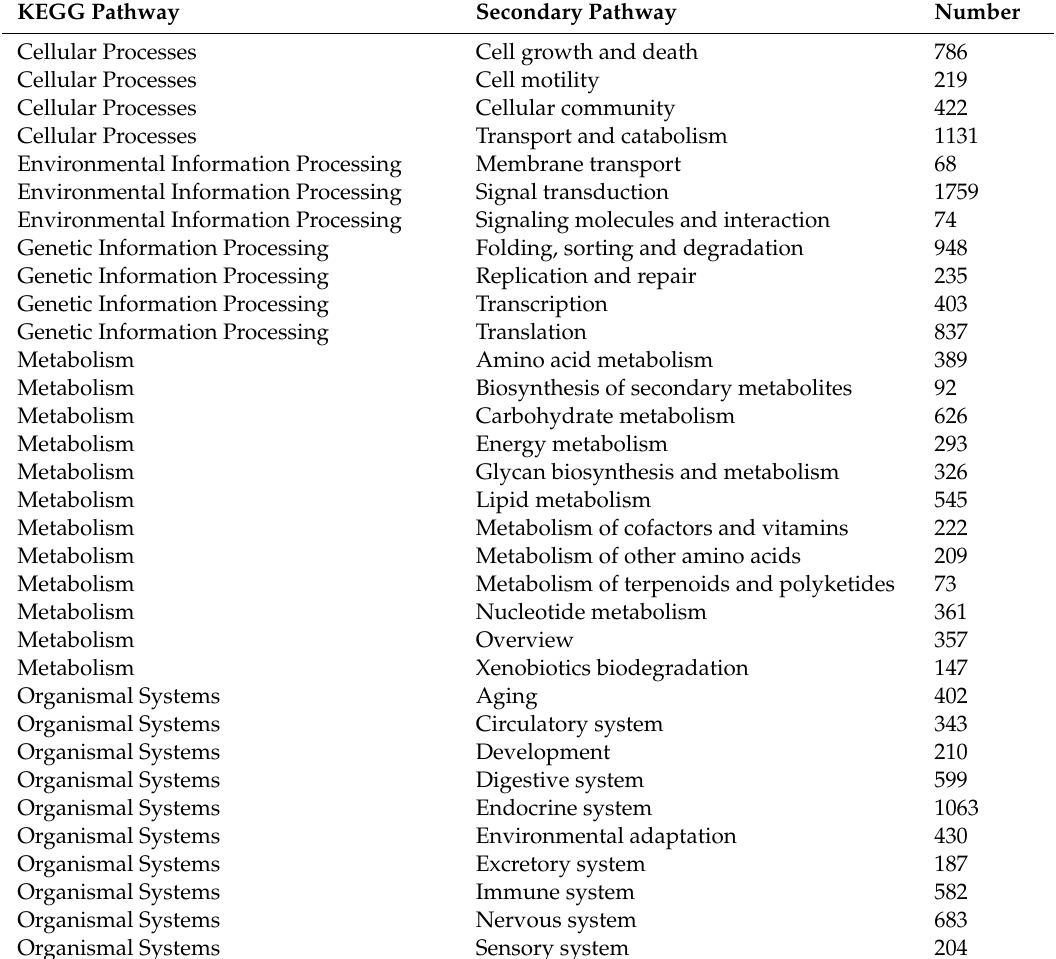
Table 3. Kyoto Encyclopedia of Genes and Genomes (KEGG) classification of DE genes between TM and WT.